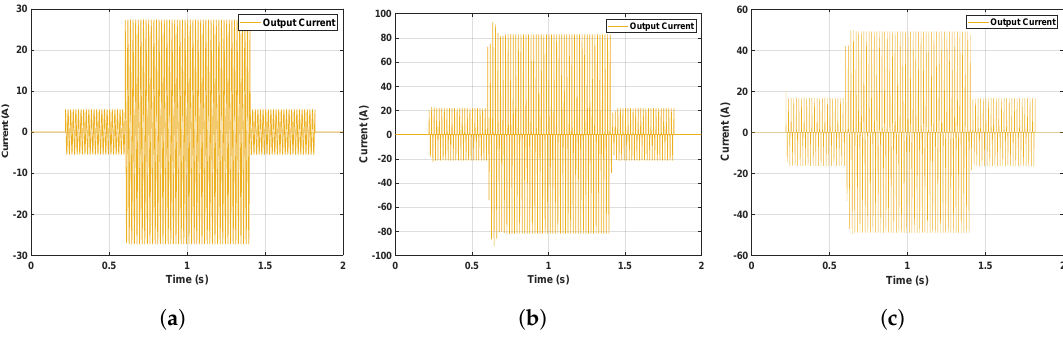
Figure 6. DER system output current curve. ( a ) 100% linear load with HC. ( b ) 100% non-linear load with HC. ( c ) 100% non-linear load without HC. Table 3. THD voltage with different load